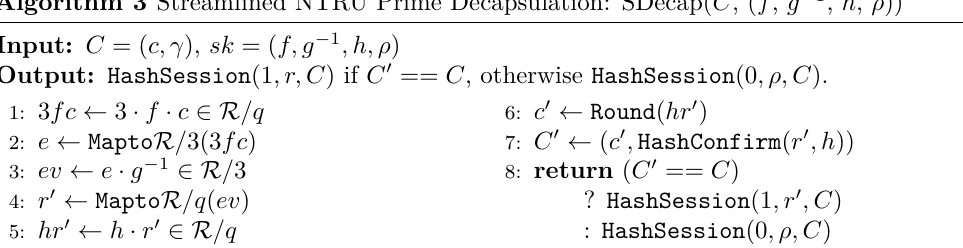
Algorithm 3 Streamlined NTRU Prime Decapsulation: SDecap( C , ( f , g − 1 , h , ρ